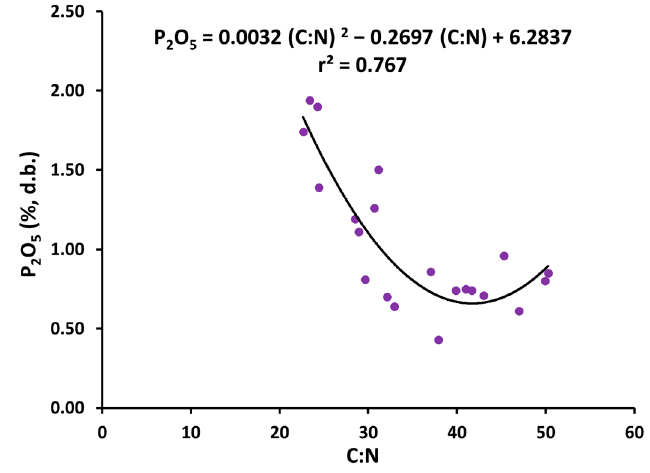
Figure 2. Variation in total phosphorous (P 2 O 5 ) content with respect to C:N.